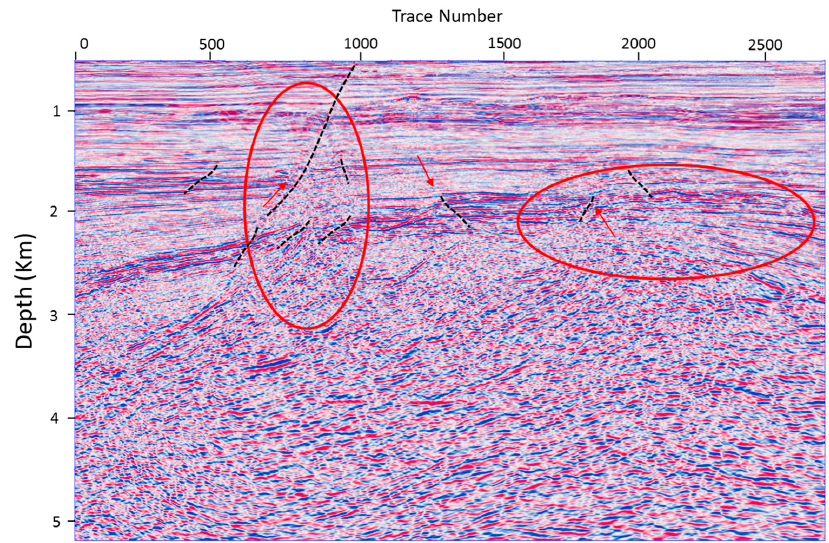
Figure 14. Pre-migrated preserved diffractions following the application of the plane-wave destruction (PWD) filtering on zero-offset data.